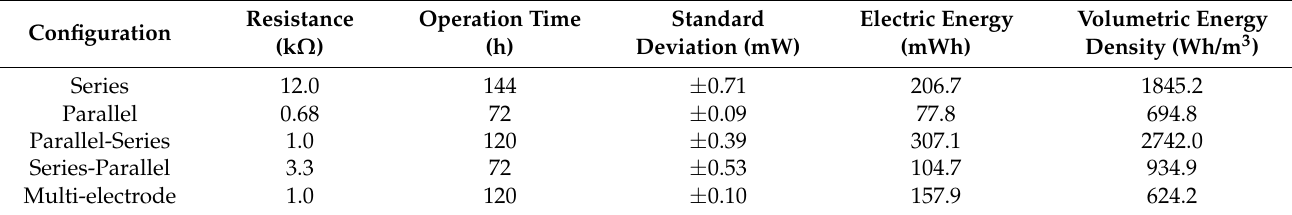
Table 6. Electric energy production for each